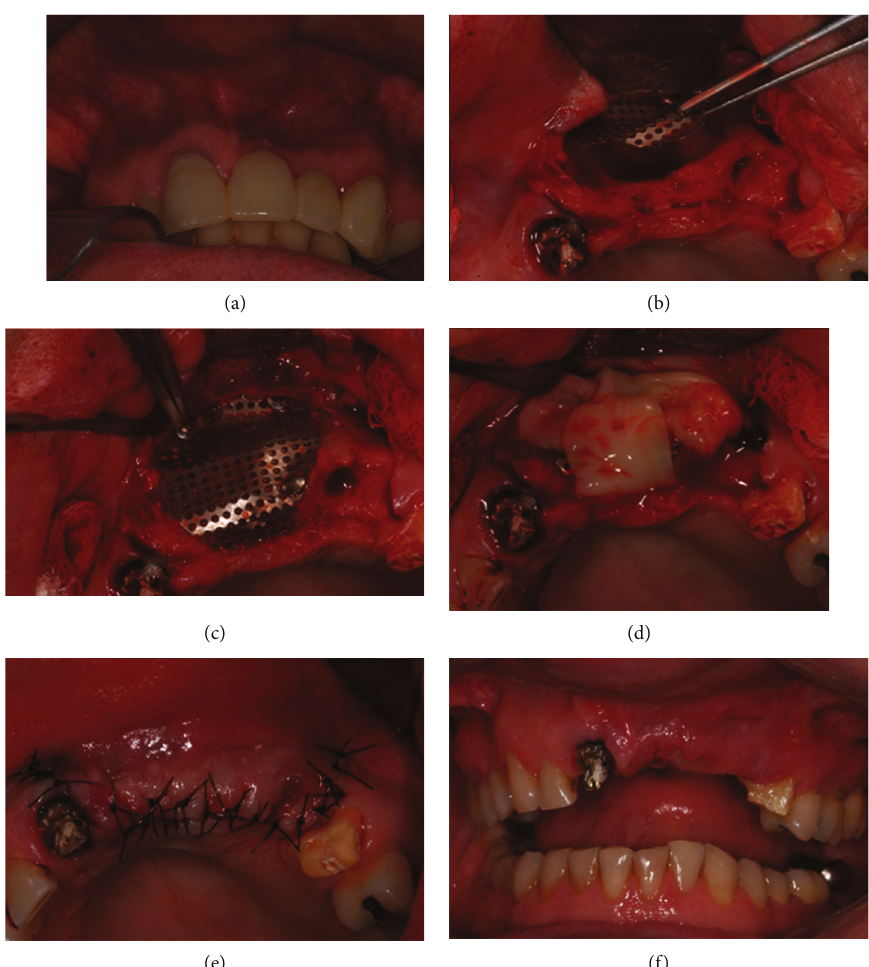
Figure 1: (a) Initial case. (b) Surgical bed preparation. It is possible to observe the bone defect in the region. (c) Xenogeneic bone and mesh in the region correcting the bone defect. (d) Adaptation of PRF membrane to the already-repaired tissue. (e) Surgical bed suture. (f) Removal of stitches without signs of in fl ammation or infection, good tissue